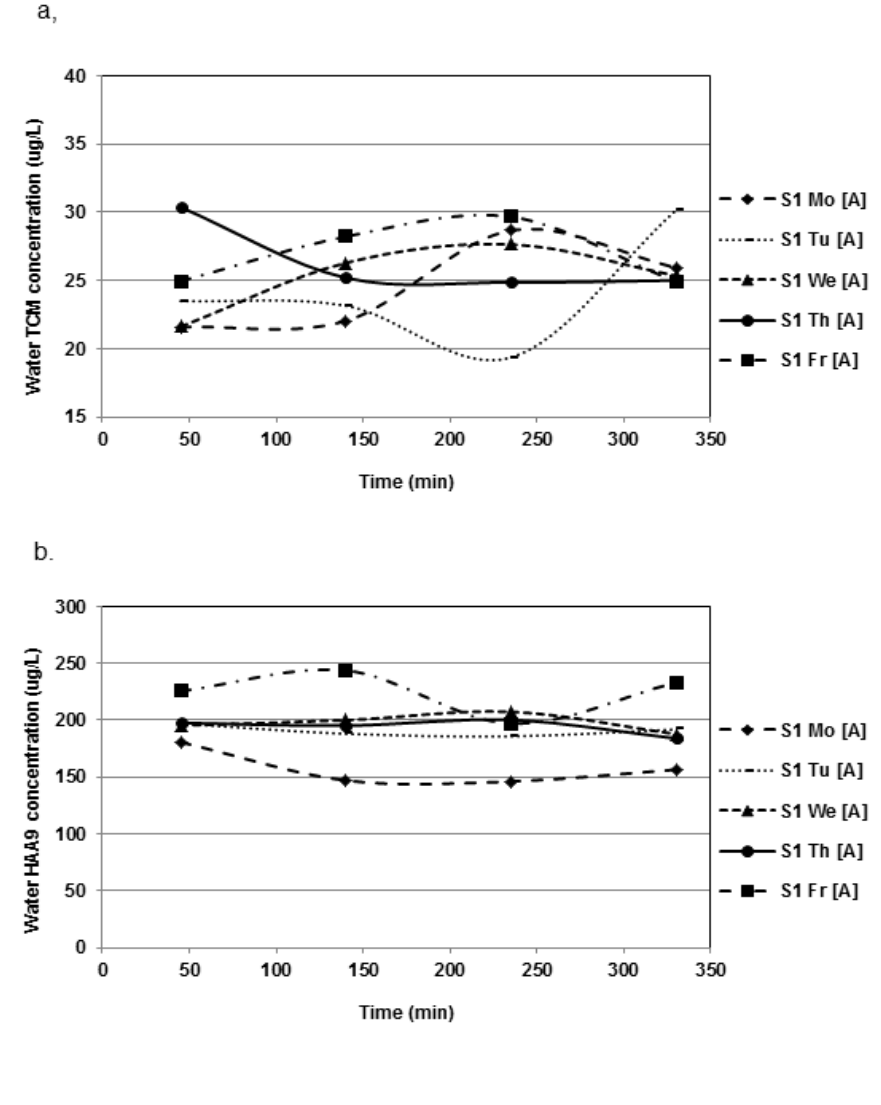
Figure 1. Mean DBP water concentrations (µg/L) in the swimming pool [A] during the four sampling periods of each day of the campaign S1 (Time = 0 min (9:00 am)–350 min (2:50 pm)). ( a ) TCM; ( b ) HAA9; ( c )